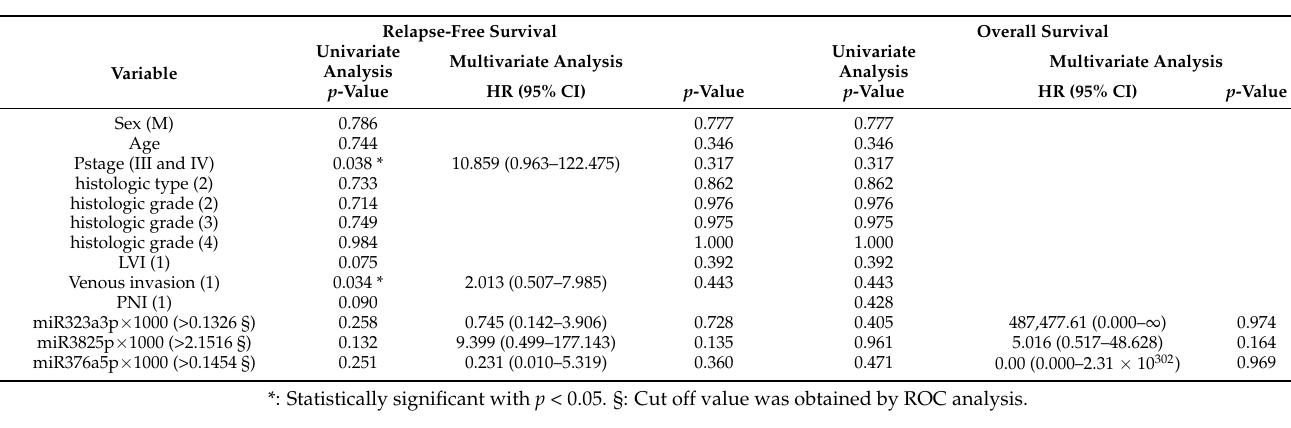
Table 3. Univariate and multivariate analysis of overall survival.